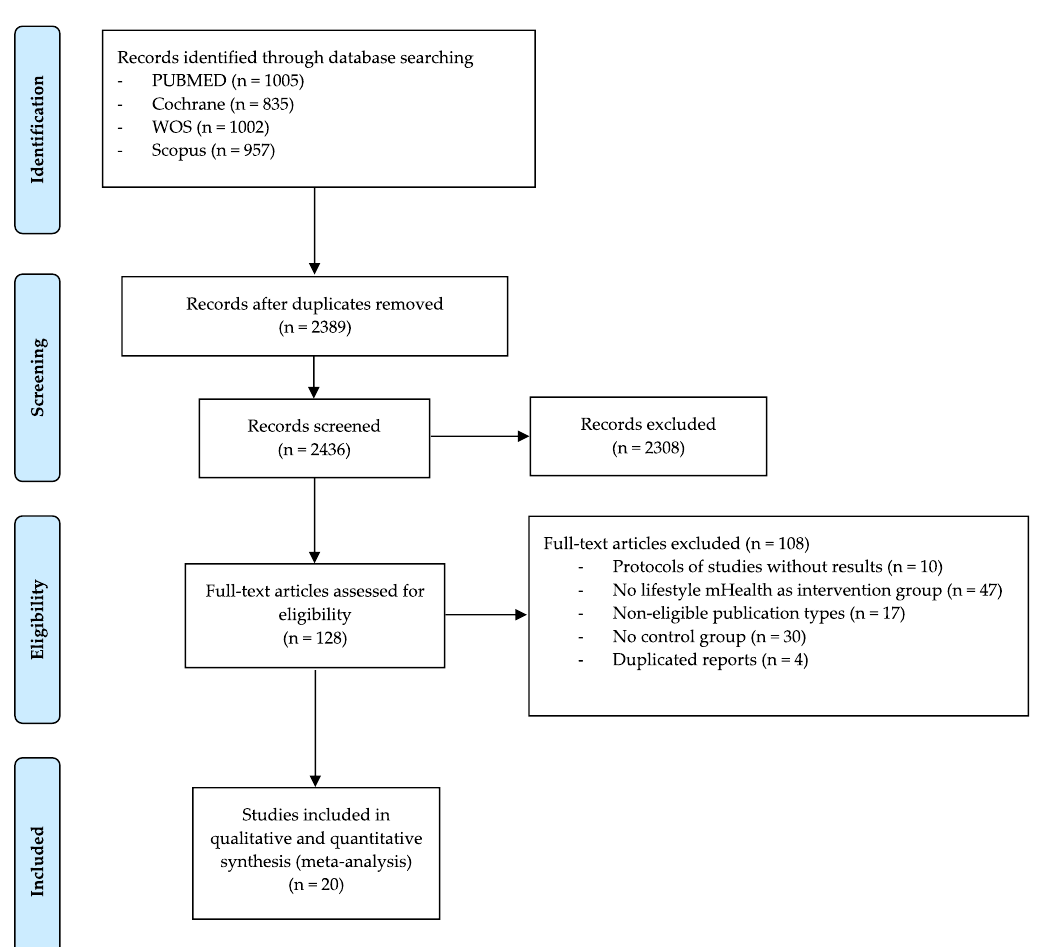
Figure 1. Preferred Reporting Items for Systematic Reviews flowchart.